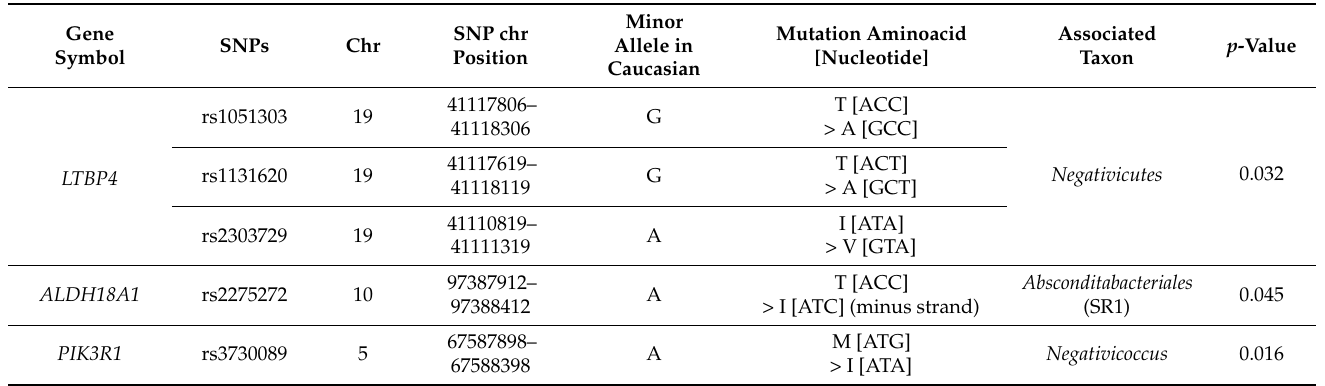
Figure 13. Heatmap of Spearman correlation values between minor alleles in selected SNPs of interest genes (rows) and taxa showing different abundance results in DESeq2 analyses (columns). Genes with any minor allele of relative SNP counted are not reported. p -values lower than 0.05 are marked with an asterisk. Table 3. Associations between the skin microbiota and